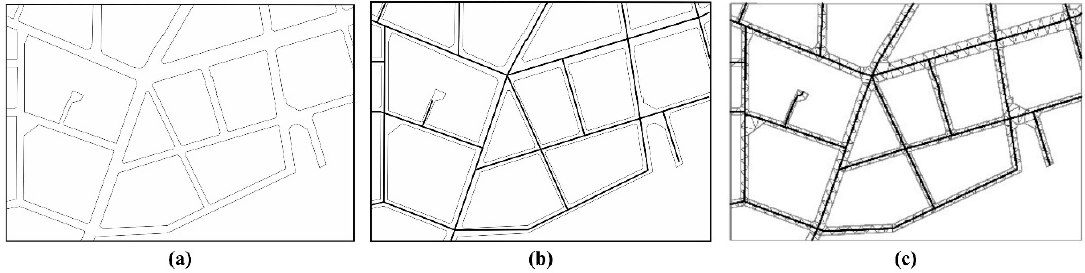
Figure 14. Reliability test and analysis: ( a ) original data, ( b ) split line obtained with the proposal by Haunert and Sester [25] and ( c ) split line obtained using our method.